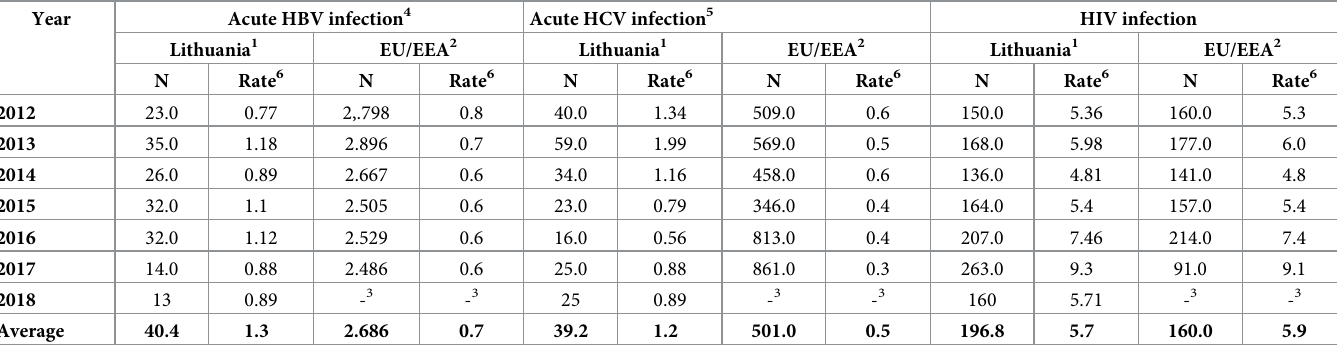
Table 6. Cases of HBV, HCV and HIV infections reported in Lithuania and Europe.